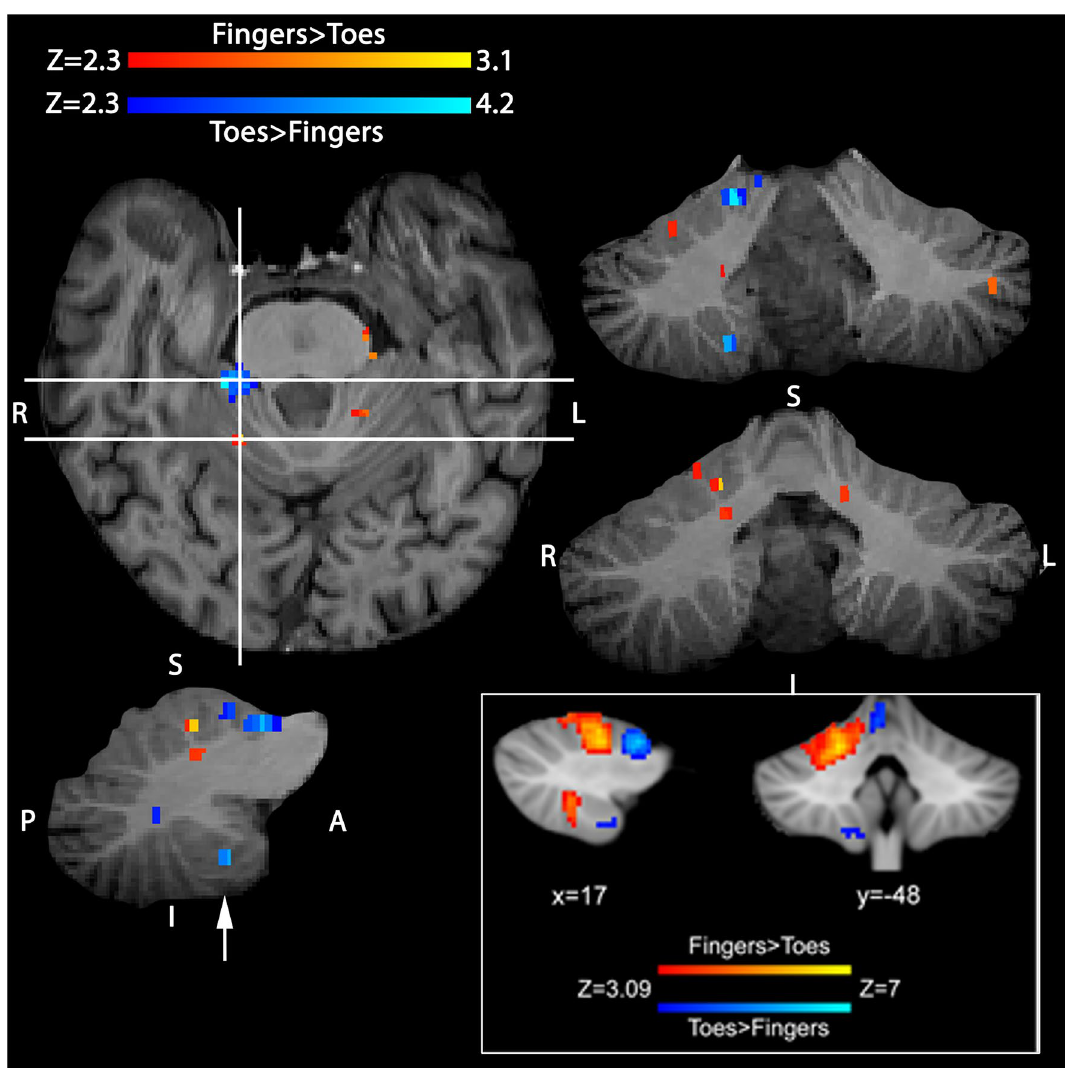
Figure 3. Pre-surgical cerebellar sensorimotor mapping with fMRI in a single patient (M4) undergoing posterior fossa ependymoma resection. Figure demonstrates two contrasts of sensorimotor activity (paced movement): (1) fingers greater than toes, shown in red/yellow, and (2) toes greater than fingers, shown in blue/ light-blue on axial, coronal and sagittal sections, with an uncorrected significance threshold of P < 0.01 (i.e. Z > 2.3) superimposed on the subject’s high-resolution T1-weighted volumetric data. Horizontal lines on the axial slice demonstrate the y locations of coronal views to the right, vertical line indicates the x location of the sagittal slice immediately below. Note the activated region in the inferior posterior cerebellar lobe from the contrast toes greater than fingers, approximately 8 mm from the cerebellar surface shown with an arrow.